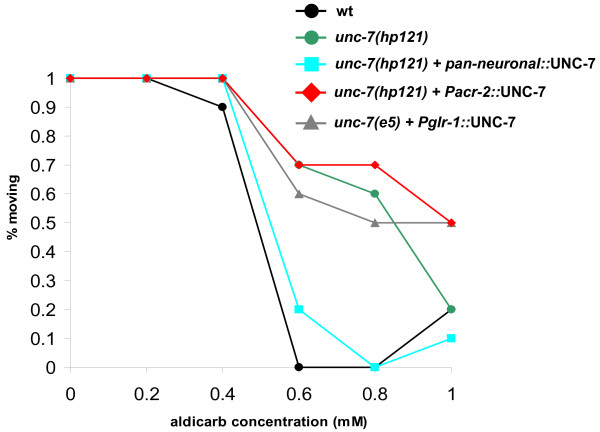
Tissue specificity of UNC-7 expression for aldicarb phenotype. unc-7(hp121) animals expressing UNC-7 by pan-neuronal (Prgef-1), cholinergic (Pacr-2) and interneuron (Pglr-1) promoters were assayed for aldicarb sensitivity. Representative results of a same-day experiment on the percentage of mobile animals after 240 minutes of aldicarb exposure at indicated concentrations (see Methods, n = 10 animals per strain). Pan-neuronally expressed UNC-7 rescued aldicarb sensitivity, but expression of UNC-7 in cholinergic or interneurons failed to rescue aldicarb sensitivity.